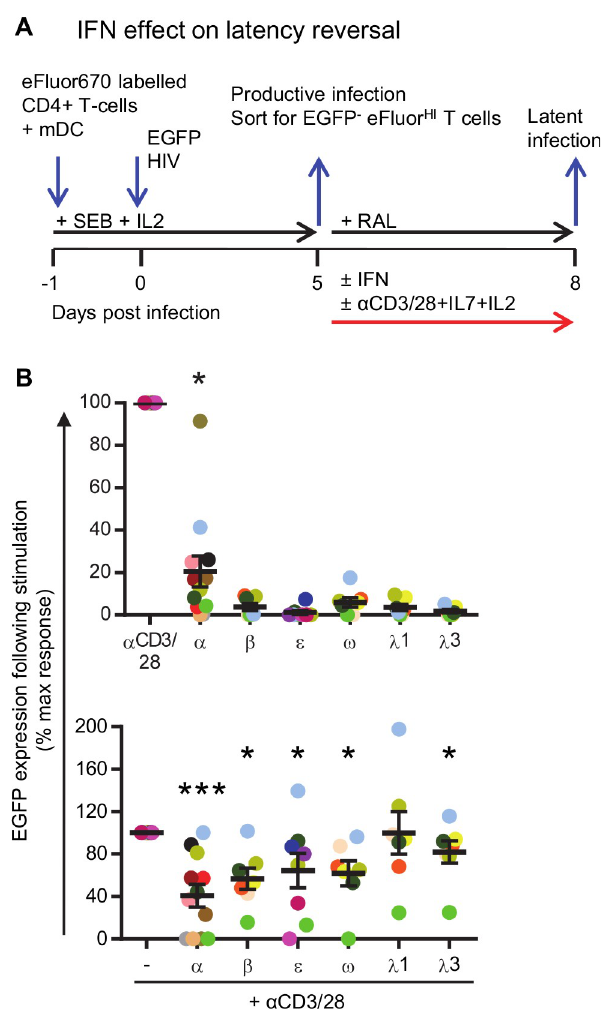
Fig 3. IFN α but not other type I or III IFNs induce expression of HIV. A: Experimental design to determine the effect of IFN on reversal of latent HIV. Resting CD4 + T cells were co-cultured with mDC, infected with EGFP-HIV and day 5 post-infection sorted for CD3 + HLA-DR - eFluor hi EGFP - . Sorted cells were cultured in the presence of an HIV integrase inhibitor (RAL) and either left untreated, cultured with 100 U/mL IFN, activated with anti-CD3/CD28+IL-7 +IL-2 or activated with anti-CD3/CD28+IL-7+IL-2 in the presence of 100 U/mL IFN B: After 3 days, the cells were harvested and EGP expression quantified by flow cytometry. To calculate the IFN-induced EGFP expression, EGFP expression in unstimulated conditions (background EGFP) was subtracted from EGFP in stimulated conditions. The IFN-induced EGFP expression is then shown as a percentage of maximal stimulation i.e. following stimulation with anti-CD3/CD28+IL-7+IL-2 minus background EGFP expression. Black lines indicate median values and each circle represents an individual donor (n = 7–12 donors). Statistical comparisons were made between IFN treated and untreated samples (top panel) or IFN+anti-CD3/CD28+IL-7+IL-2 and anti-CD3/CD28+IL-7+IL-2 (bottom panel). � p < 0.05, ��� p < 0.001, ns = not significant as determined with Wilcoxon matched pairs signed rank test. expressing this value as a percentage of maximal stimulation with anti-CD3/CD28+IL-7+IL-2 which, had a mean (range) value of 21 (0–91)%, (Fig 3B). When IFN α was combined with anti-CD3/CD28+IL-7+IL-2, virus expression was inhibited by 59% compared to anti-CD3/ CD28+IL-7+IL-2 without IFN α (%max stim 41(0–100)). None of the other IFNs increased EGFP expression from the latently infected cells (Fig 3B, S3 Fig) and all IFNs except IFN λ 1, inhibited virus expression when combined with anti-CD3/CD28+IL-7+IL-2 compared to anti- CD3/CD28+IL-7+IL-2 without IFN (Fig 3B, S3 Fig). Compared to the maximal EGFP